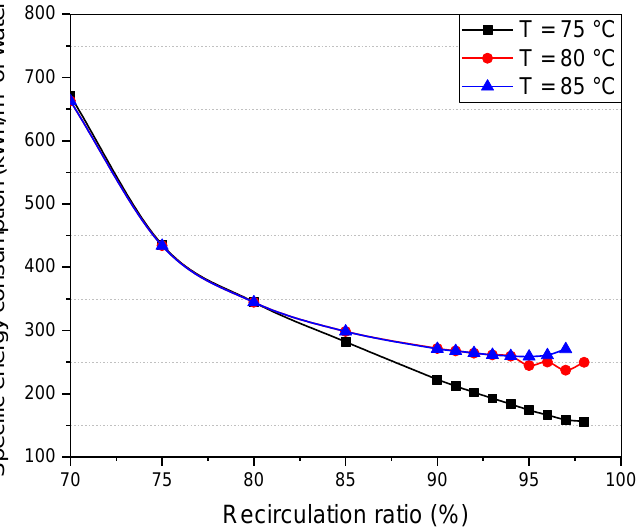
Figure 9. Specific energy consumption as the recirculation ratio increases for the set-points of 75, 80, 85 °C.